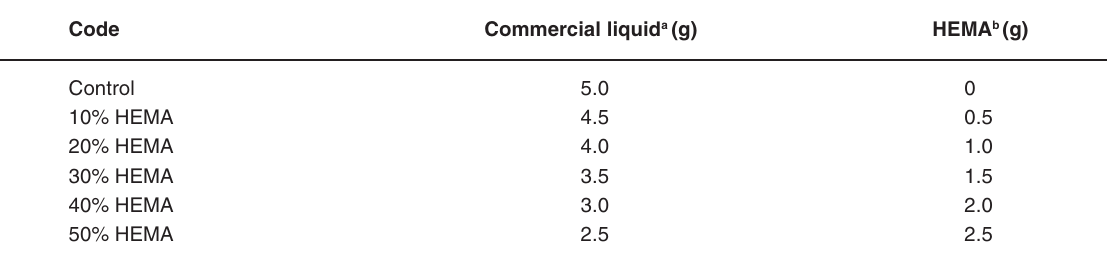
Control = Conventional filling glass ionomer cement (Fuji II, GC Corp., Tokyo, Japan). a = Liquid component of Fuji II